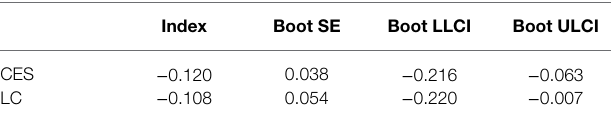
TABLE 8 | Index of moderated